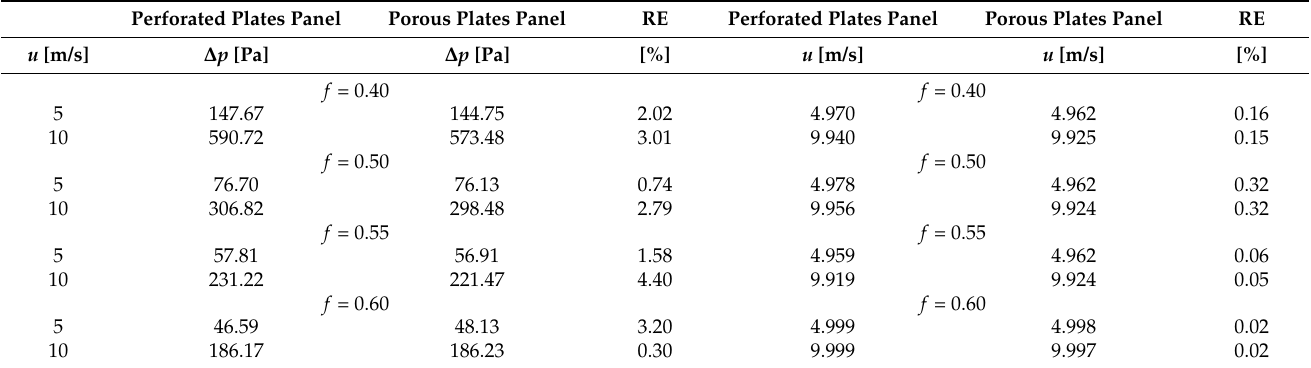
Table 6. Numerical results of pressure drop for perforated plate and equivalent porous plate. Perforated Plates Panel Porous Plates Panel RE Perforated Plates Panel Porous Plates